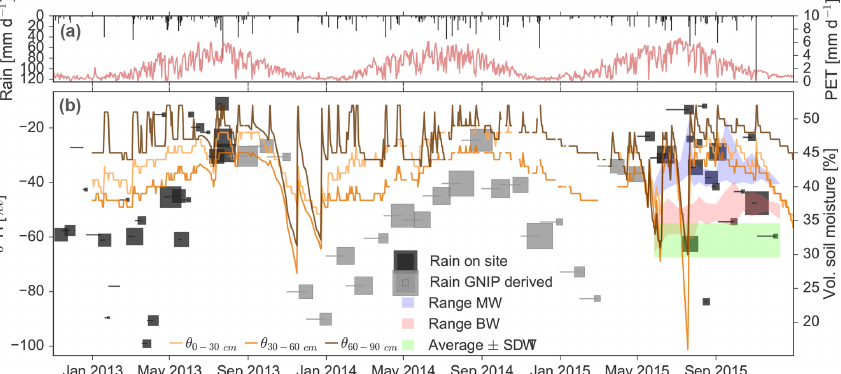
Figure 5. Long-term hydrological and stable isotope dynamics. (a) Daily rainfall (bars) and potential evapotranspiration (PET; red line). (b) Rainwater δ 2 H values and soil moisture dynamics. Note that the size of the black and grey squares indicates the rainfall amount, and the line represents the time span of the water sample. Black squares show rainwater sampled at the study site, and grey squares show monthly values derived from GNIP data. The blue and red shaded area shows the range of mobile (MW) and bulk (BW) soil water, respectively. The green shaded area indicates the average value ± standard deviation estimated for the tightly bound water (TW).